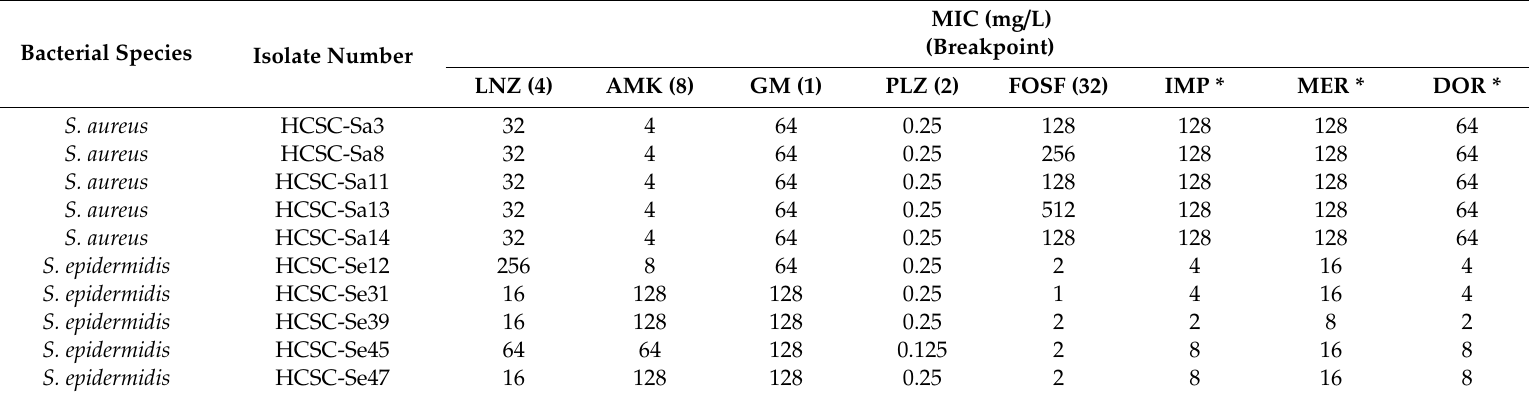
Table 1. Susceptibility of staphylococcal isolates to linezolid and several antibiotics: plazomicin, amikacin, gentamicin, fosfomycin, meropenem, imipenem and